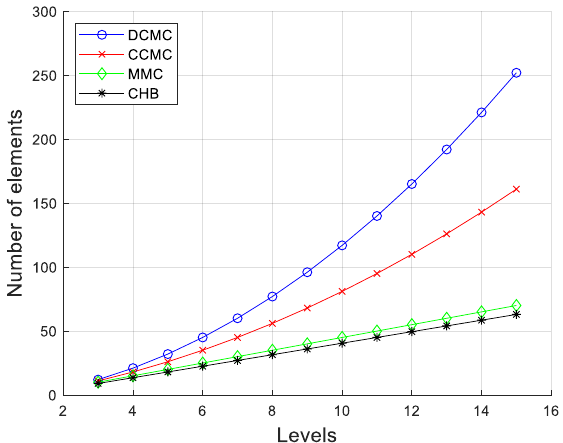
Figure 1. Comparison between classical multilevel converter